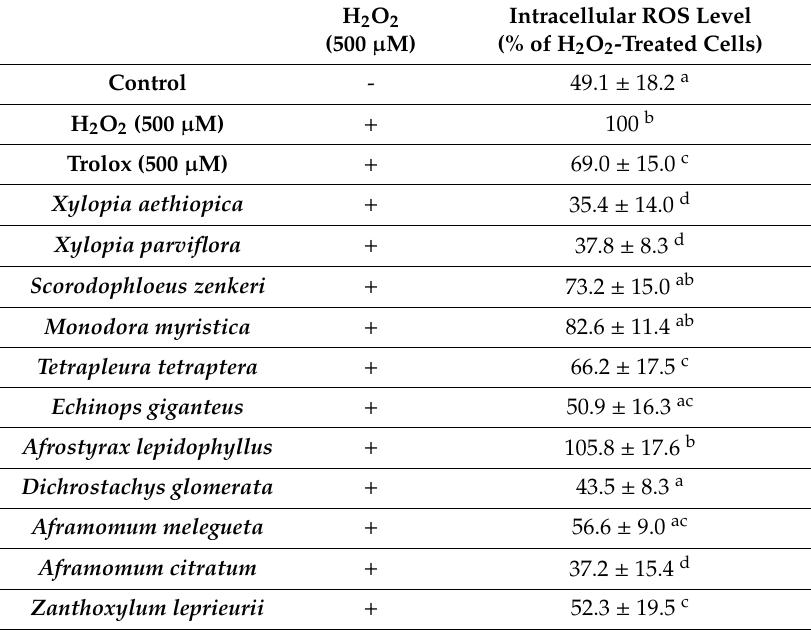
Table 2. Relative intracellular ROS production in HepG2 cells: e ff ect of spice